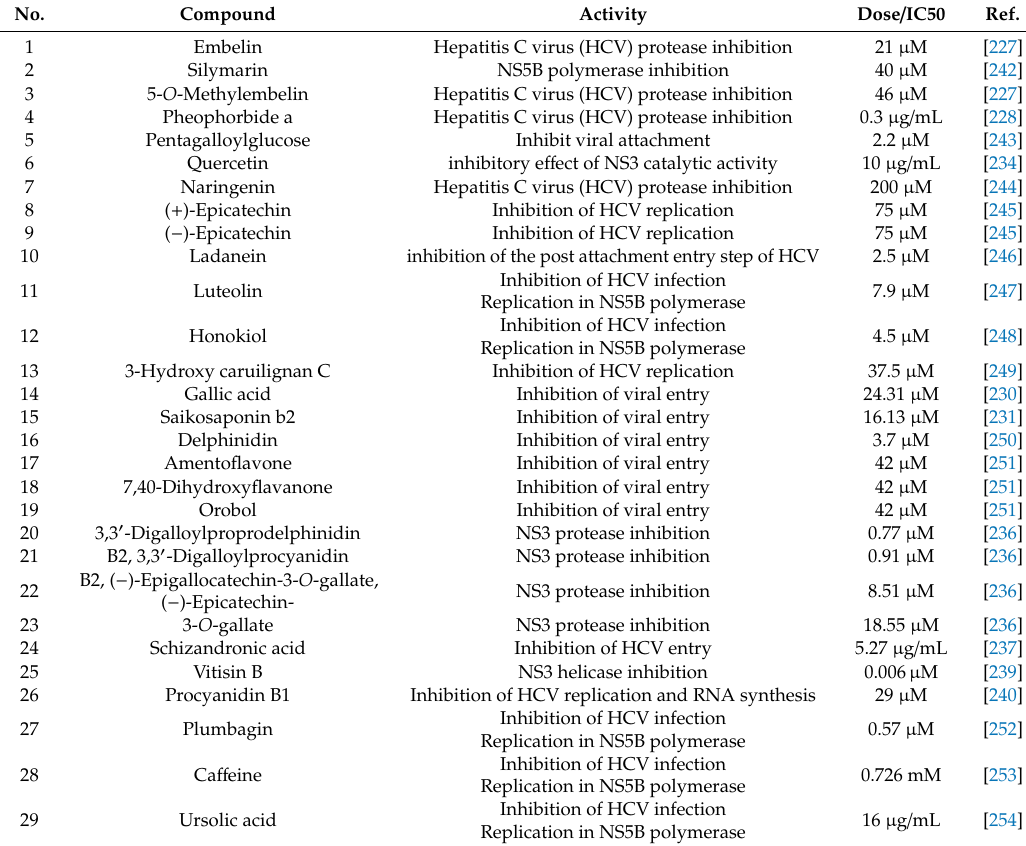
Table 8. Bioactive compounds derived from plants with anti-HCV